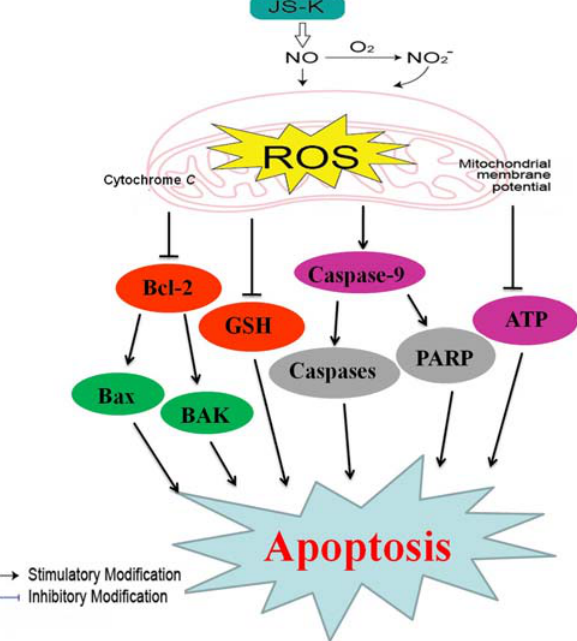
Figure 7: Cellular pathway of JS - K - induced cell apoptosis in renal carcinoma cells. JS - K - induced apoptosis of renal carcinoma cells via cytochrome c activation, repression of mitochondrial membrane potential by caspase - 9 and PARP, and ATP. ROS development will continue, which ultimately led to